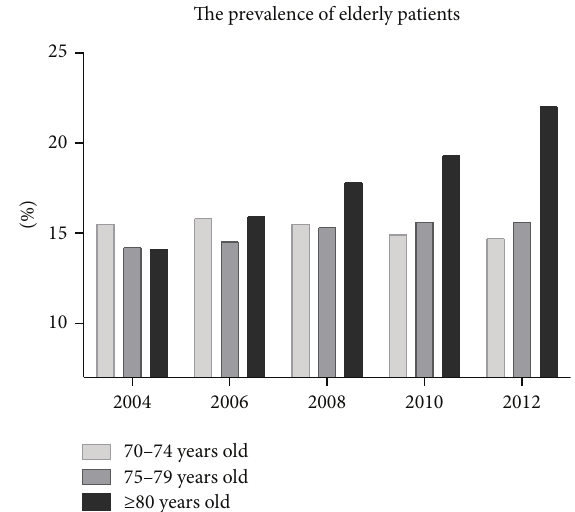
Figure 1: Prevalence of elderly patients receiving dialysis treatment in the overall Japanese population according to